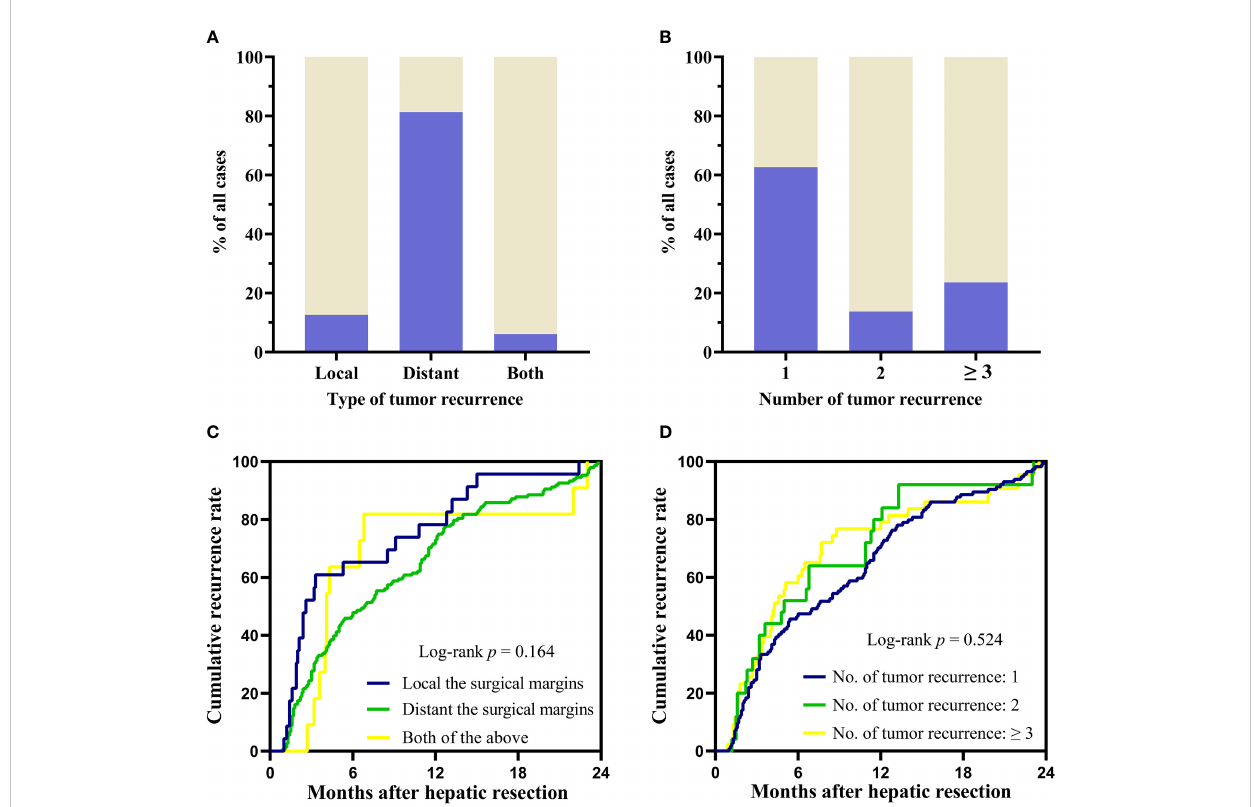
FIGURE 2 Recurrence patterns and differences between groups in TTR. (A, B) The pattern of recurrence according to the type and number of recurrent tumors. (C, D) Group differences in time to recurrence were examined with the log-rank test. TTR: time to